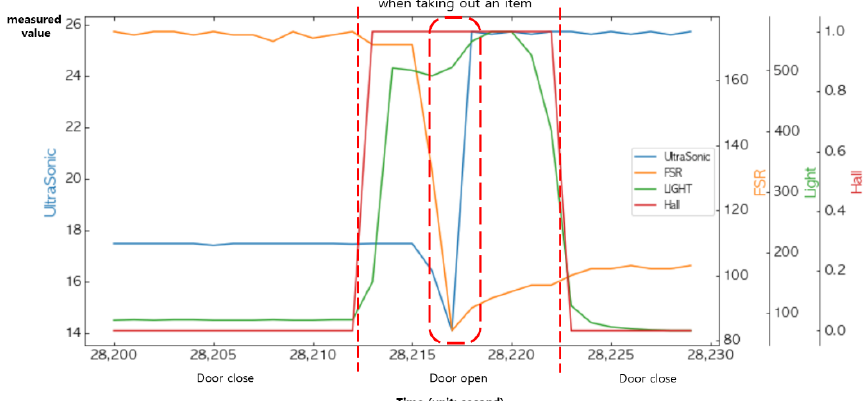
Figure 22. Changes in the sensor values when placing an item.